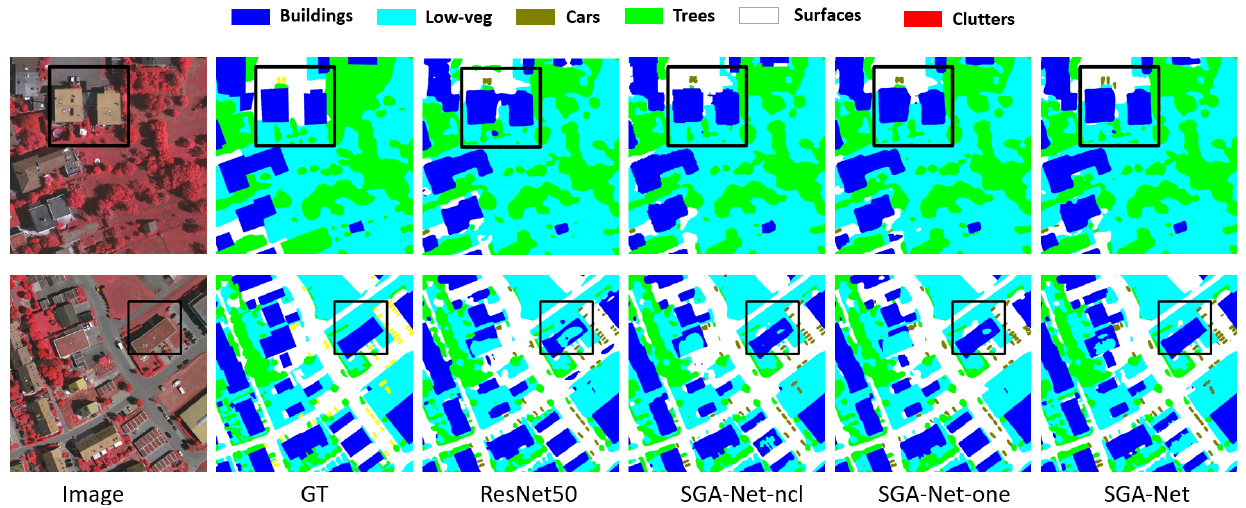
Figure 8. Visualization in the ablation study of Vaihingen dataset.